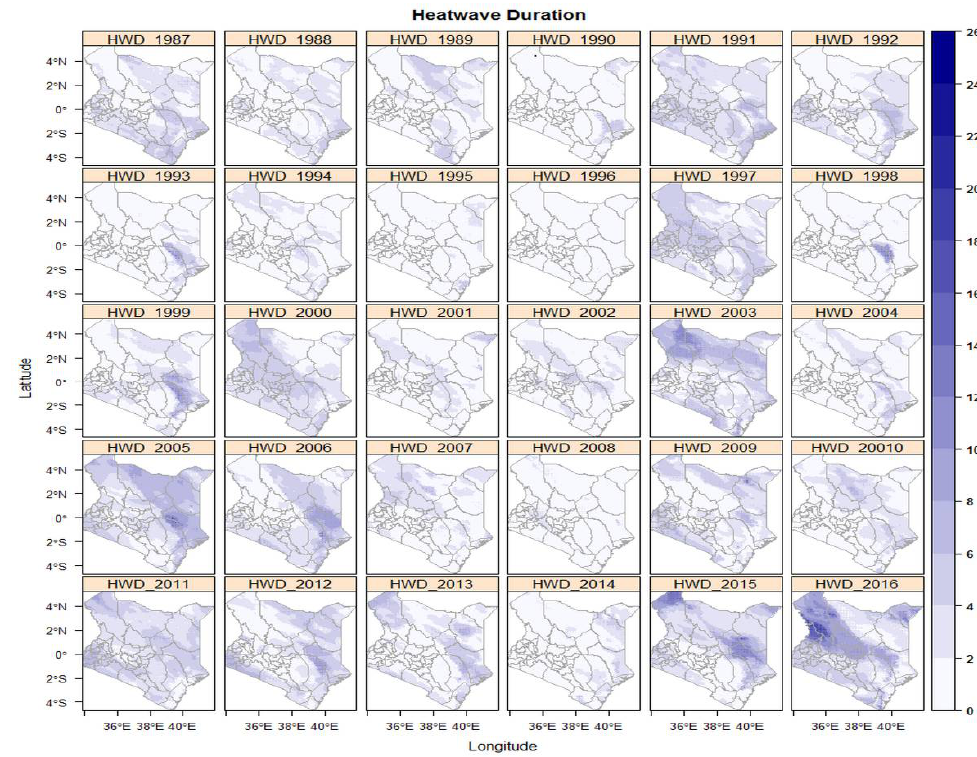
Figure 3. Duration of heatwave events of Figure 2 in number of days 1987–2016. The white (0) indicates no heatwave event, the minimum duration is 3 days.